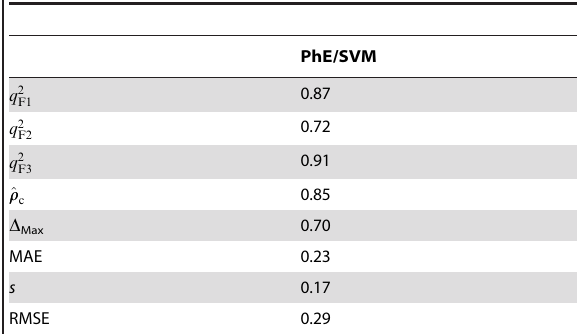
Table 4. Statistic parameters correlation coefficients q 2 , concordance correlation coefficient ( ^ rr and q 2 F3 residual ( D Max ), mean absolute error (MAE), standard deviation of residual ( s ), and RMSE evaluated by PhE/SVM in the outlier